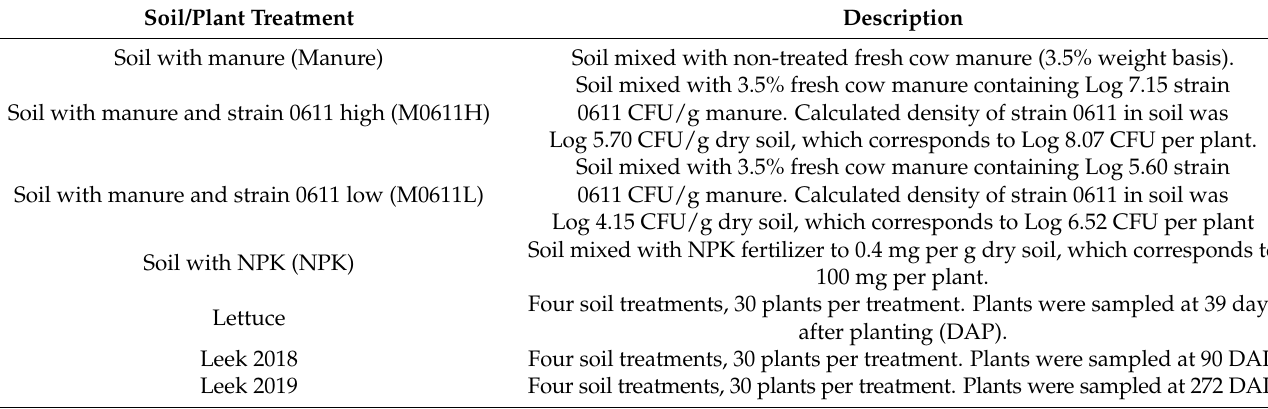
Table 1. Soil and plant treatments applied in field experimentation. Soil/Plant Treatment